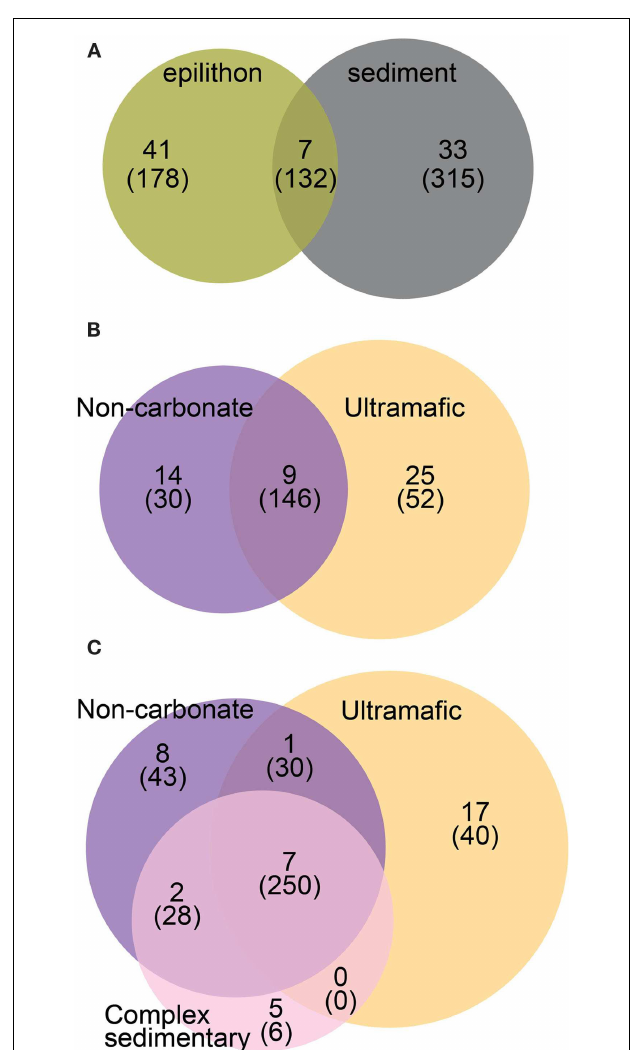
FIGURE 4 |Venn diagrams representing the overlap between samples at the following levels: (A)All OTUs grouped by habitat; (B) OTUs from epilithon samples grouped by lithology, and (C) OTUs from sediment samples grouped by lithology. Numbers represent OTUs and parenthetical numbers represent